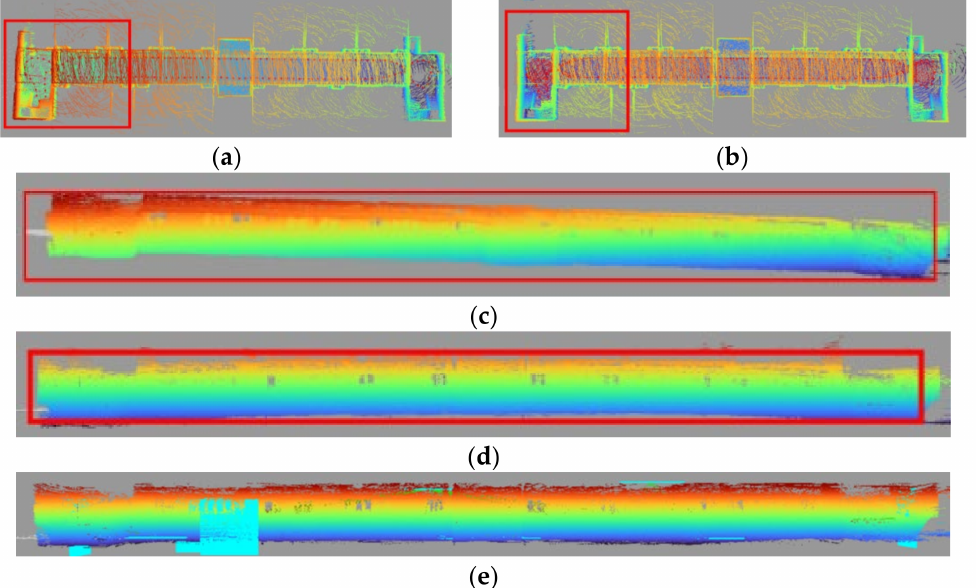
Figure 6. The effect of the automatic loop closure method in the indoor environment: ( a ) odometry drift (top view); ( b ) corrected point cloud (top view); ( c ) odometry drift (side view); ( d ) corrected point cloud (side view); ( e ) side view of the corrected point clouds after ground and plane detection. Top and perspective views of the corrected final 3D maps of the indoor and outdoor environments are in Figure